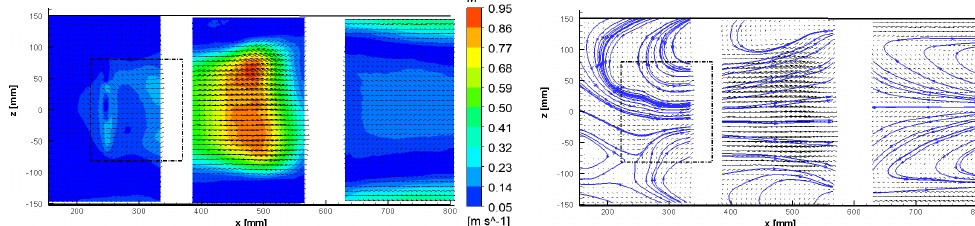
Figure 27. PIV measurements, the magnitude of time-averaged 2D velocity (left panel) and vector lines in horizontal plane ( y = 135mm )